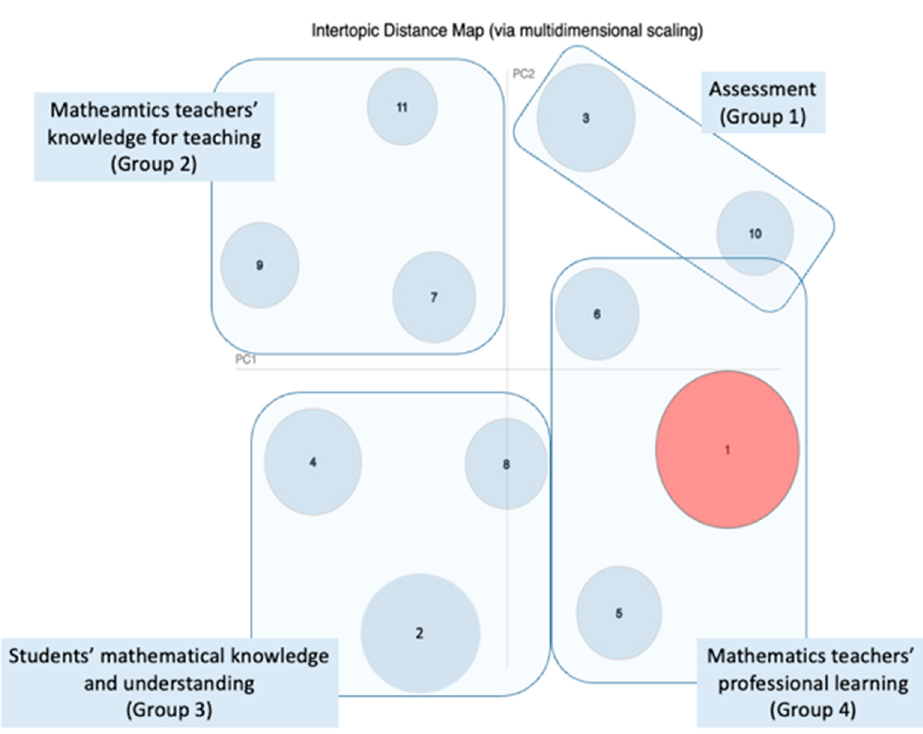
Figure 7. Intertopic distance map between topics.